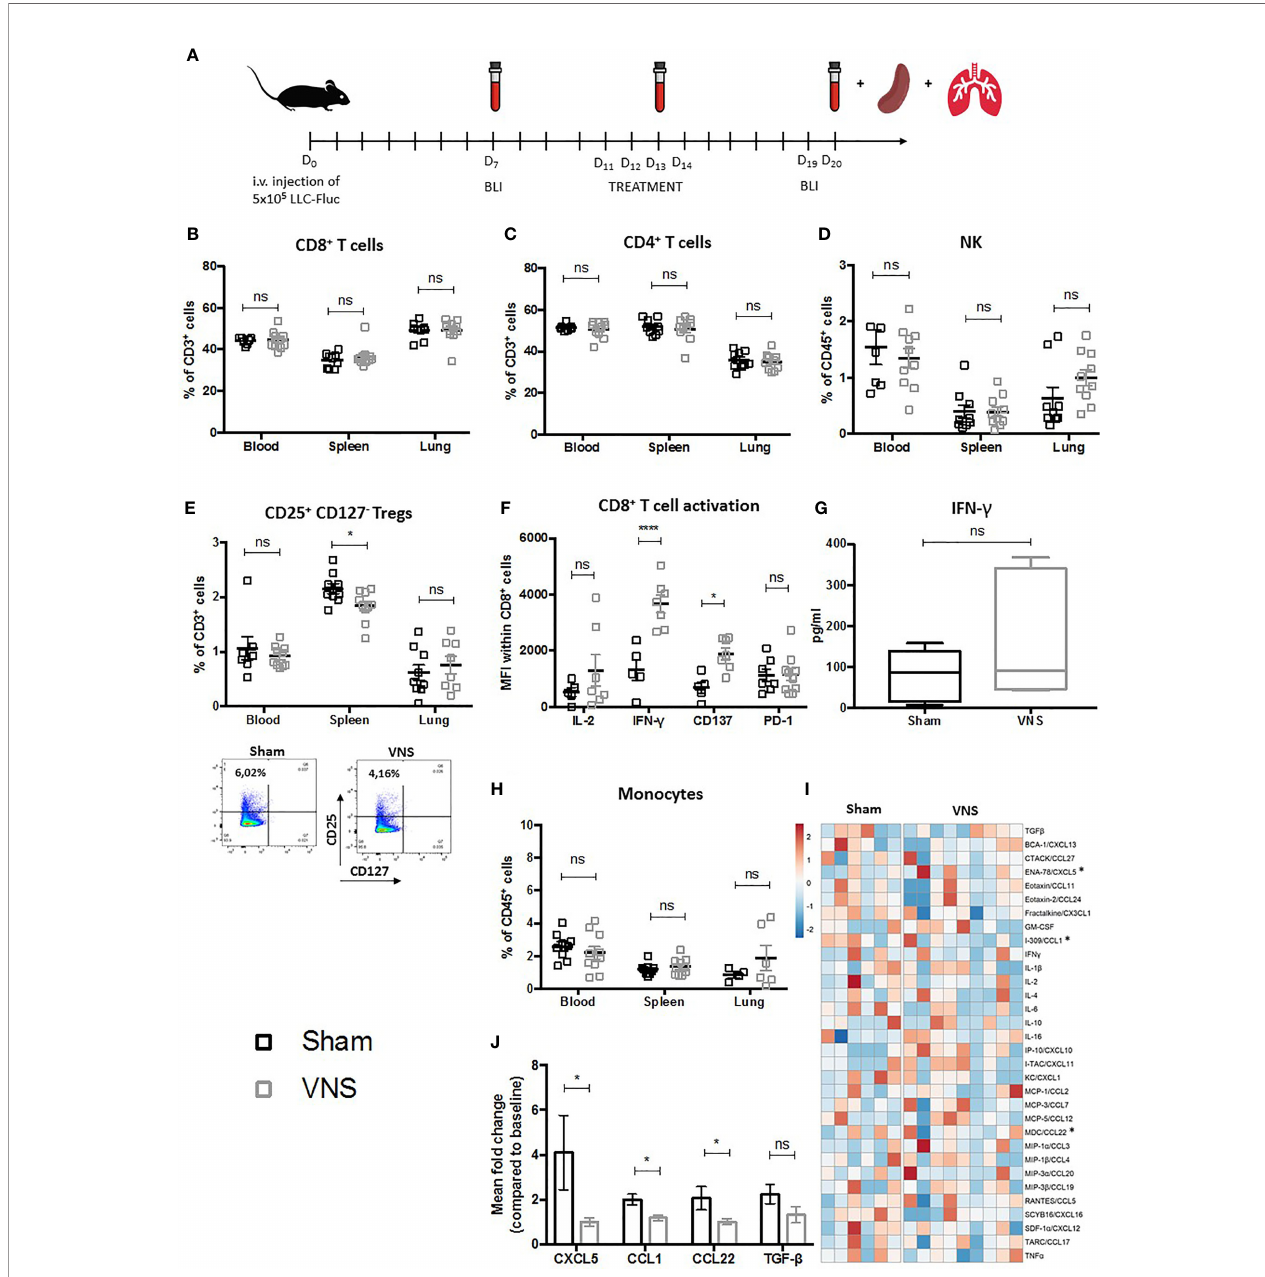
FIGURE 1 | Schematic representation of preclinical experimental setup and evaluation of immune cell populations in lung tumor bearing mice treated with VNS. (A) C57BL/6 mice were i.v. injected with 5x10 5 Fluc expressing LLC tumor cells. Seven days later in vivo BLI was performed to randomize mice with similar photon counts to the VNS treated, RT treated, RT+VNS treated or sham treated control group. Mice were daily treated with VNS (25Hz) and/or RT (3,2 Gy) for four consecutive days starting at day eleven after tumor injection. Blood samples were collected at day 7 (baseline), day 13 and day 20. On day 20 after tumor injection, mice were euthanized to collect perfused lungs and spleens. (B – E, H) Flow cytometric analysis of (B) CD8 + T cells, (C) CD4 + T cells, (D) CD56 + NK cells, (E) CD4 + CD25 + CD127 - Tregs with on the right a representative dot plot from splenic CD4 + CD25 + CD127 - Tregs from a sham or VNS treated animal and (H) CD11b + Ly6C + monocytes in blood, spleen and lung TME. (F, G) Cell suspensions derived from murine lung tissue were co-cultured with LLC cells at a 10:1 ratio for 24 hours. Next, expression of IL-2, IFN- g , CD137 (4-1BB) and PD-1 was assessed on the CD8 + T cells speci fi cally using fl ow cytometry (F) and IFN- g secretion was evaluated via a mouse IFN- g ELISA kit (G) . (I, J) Data obtained from a 31-plex cytokine array on plasma samples obtained from VNS or sham treated mice. (I) Heatmap of the 31 different cytokines, in which the meanfold change of each cytokine concentration compared to baseline is visually represented with red, white, and blue to indicate high, median, and low, respectively. (J) Box plots show the signi fi cant fold changes of ENA-78 (CXCL5), I-309 (CCL1), MDC (CCL22) next to the non-signi fi cant decrease of TGF- b in the same plasma samples. Data represent three pooled experiments six days after the last treatment. Data are shown as mean ± SD of n>9 (VNS) and n>6 (sham). *P < 0,0332; ****0,0001 by two-tailed unpaired t-tests. ns, non signi fi